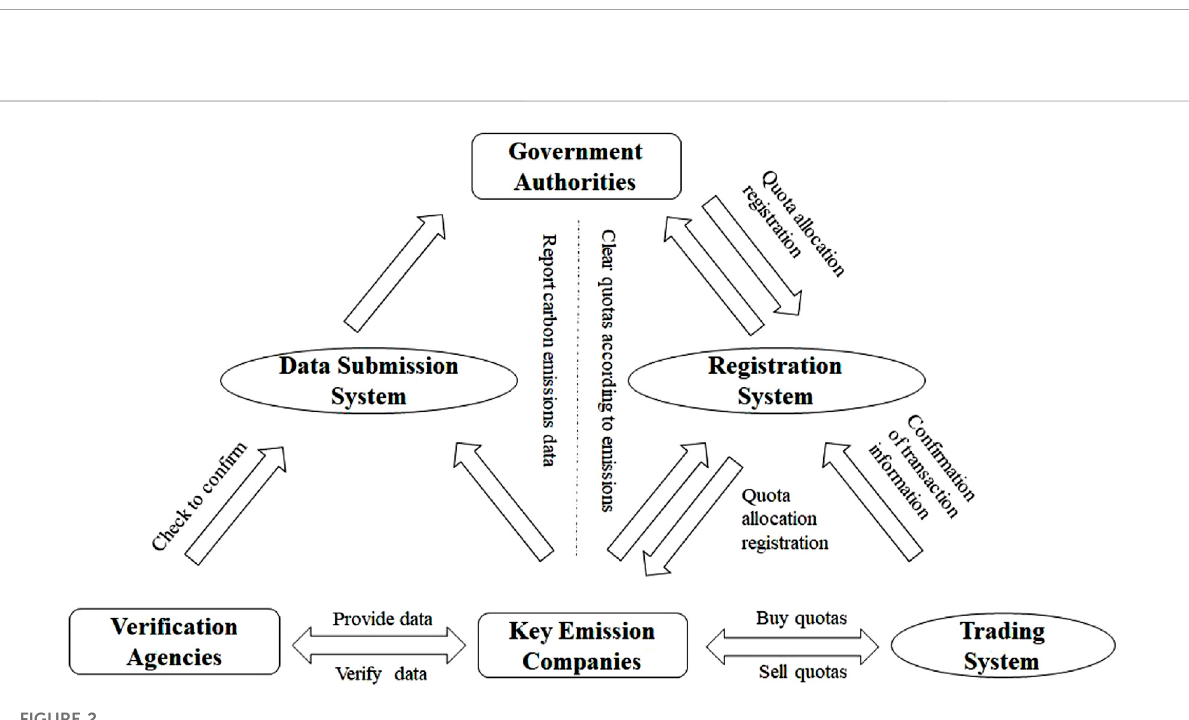
FIGURE 2 2020 National carbon emission rights registration, trading and settlement management mechanism. Source: Compiled and produced according to the 2021 measures for the administration of carbon emission trading issued by the general of fi ce of ecology and environment (trial implementation) and other relevant